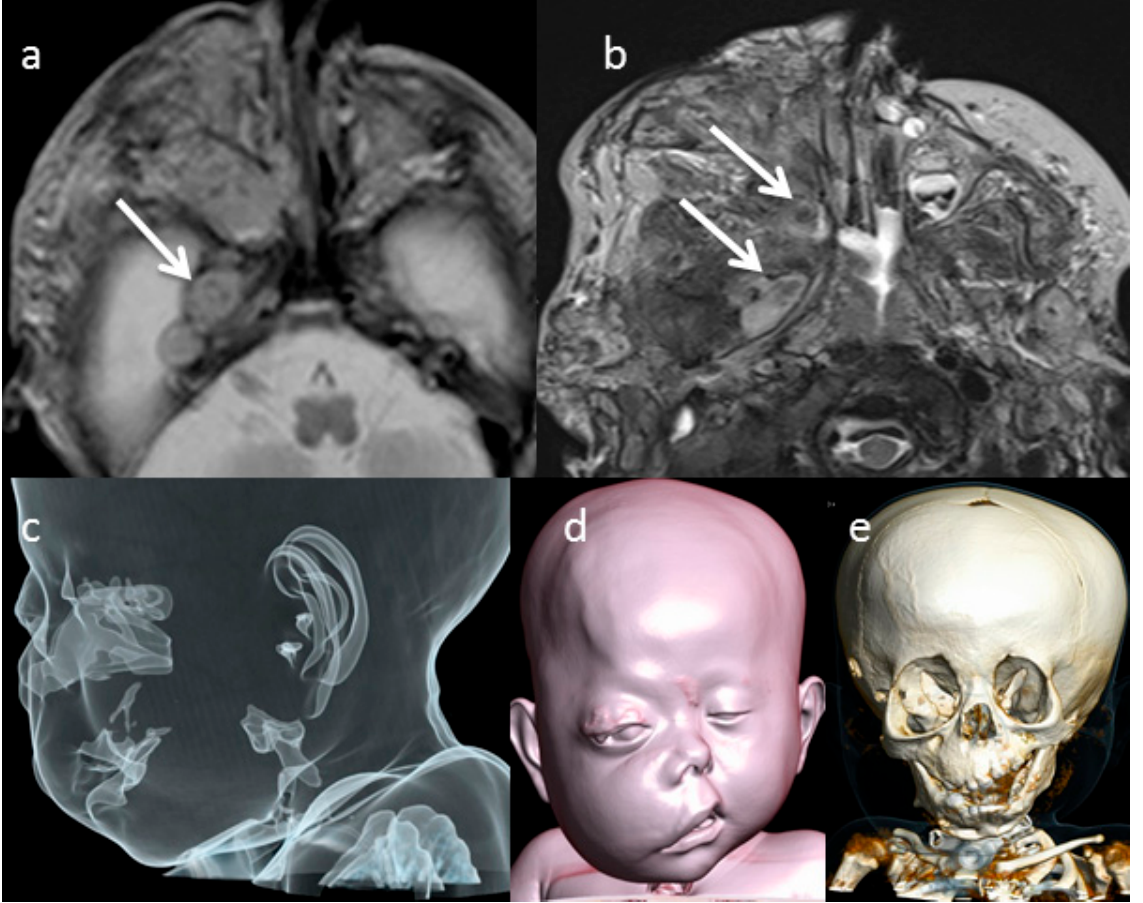
Figure 2. Axial T2-w MRI performed at diagnosis ( a ) and at the follow-up ( b ) showed the typical “target sign” represented by a rim of high signal peripherally and low signal centrally (( a , b ) white arrows). Computed tomography (CT) 3D reconstructions ( c – e ) showed the swelling of the cheek and the ocular proptosis of the right eye ( d ) and the orbital enlargement ( e ).